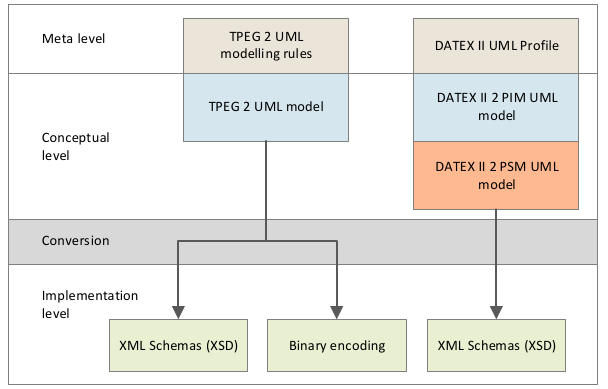
Figure 3. The Model-Driven approaches for TPEG2 and DATEX II.